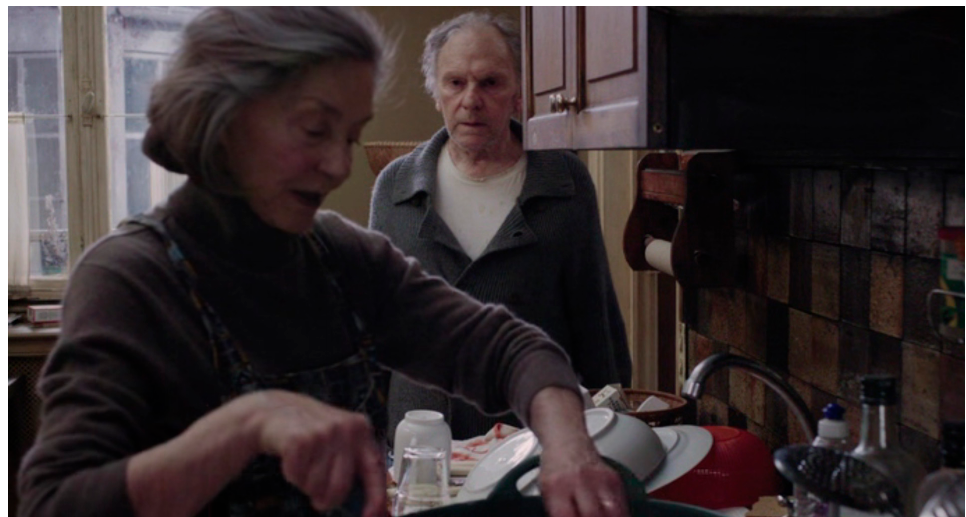
Figure 8. Georges has lost touch.